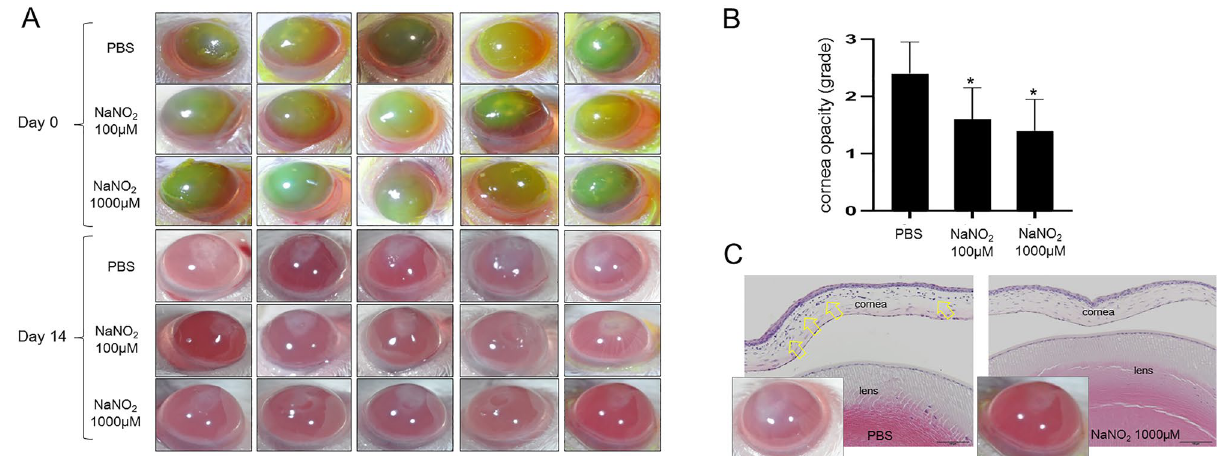
Figure 9. In vivo effect of NO on corneal opacity development after alkali burn. ( A ) Representative photographs of the alkali burned murine cornea at day 0 and 14 days after injury. Green stained areas by fluorescein at day 0 represent corneal epithelial defect induced by alkali burn. Corneal opacity of NO treated corneas (100 μM and 1000 μM) was significantly better than PBS control observed at 2 weeks. ( B ) The difference of corneal opacity grades between treatments and control (PBS) was significant. However, the difference between 100 and 1000 μM of sodium nitrite treatments was not significant. ( C ) Histologic examination revealed significantly increased corneal thickness and stromal cellularity (yellow arrows) in PBS treated cornea compared to NO treated cornea. *p < 0.05, scale bar: 100